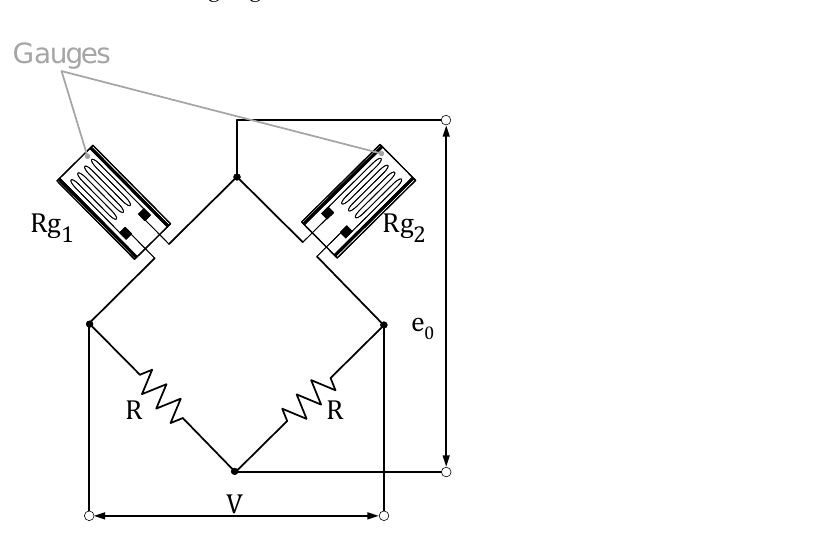
Figure 8. Signal conditioning electronics. R = fixed resistance, Rg 1 = upper strain gauge, Rg 2 = lower strain gauge, V = supply voltage, e 0 = output